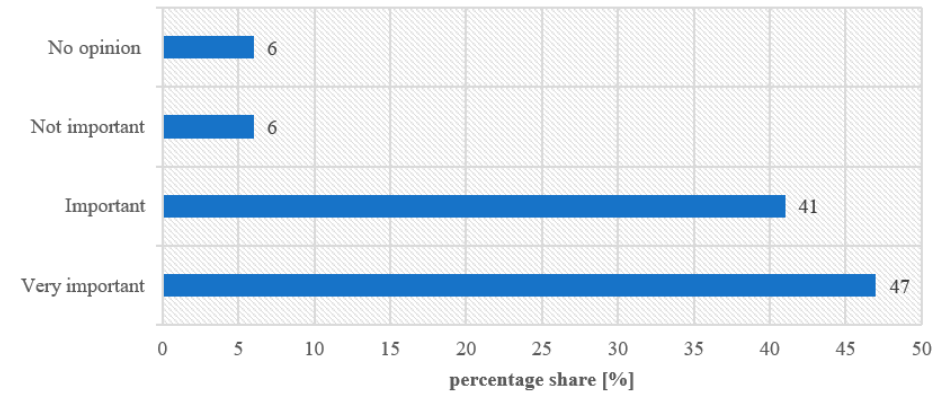
Figure 7. Concerns about using fertilizers from waste (multiple choice).